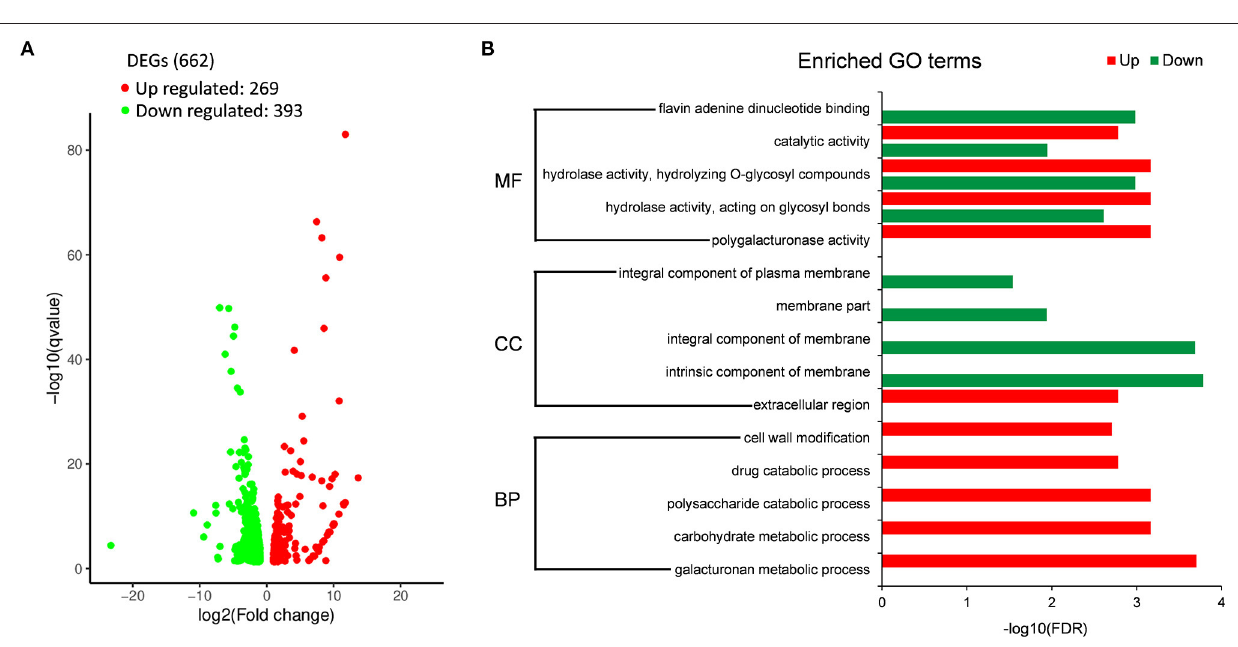
FIGURE 5 | RNA-Seq analysis of wild-type and Sscnd1 gene-silenced strains. RNA sequencing was performed between wild-type strain (WT) and Sscnd1 gene-silenced strains. Experiments contain two biological replicates. (A) The number of differentially expressed genes (DEGs) ( Sscnd1 gene-silenced strains vs. WT). (B) Significantly enriched Gene Ontology (GO) terms for up- and down-regulated